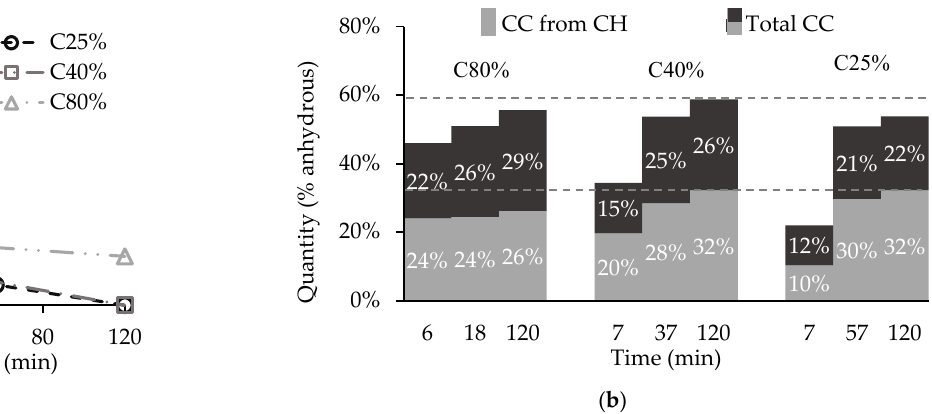
Figure 6. CH content consumption ( a ) and CC obtained from CH and total CC ( b ) for different CO 2 concentrations.